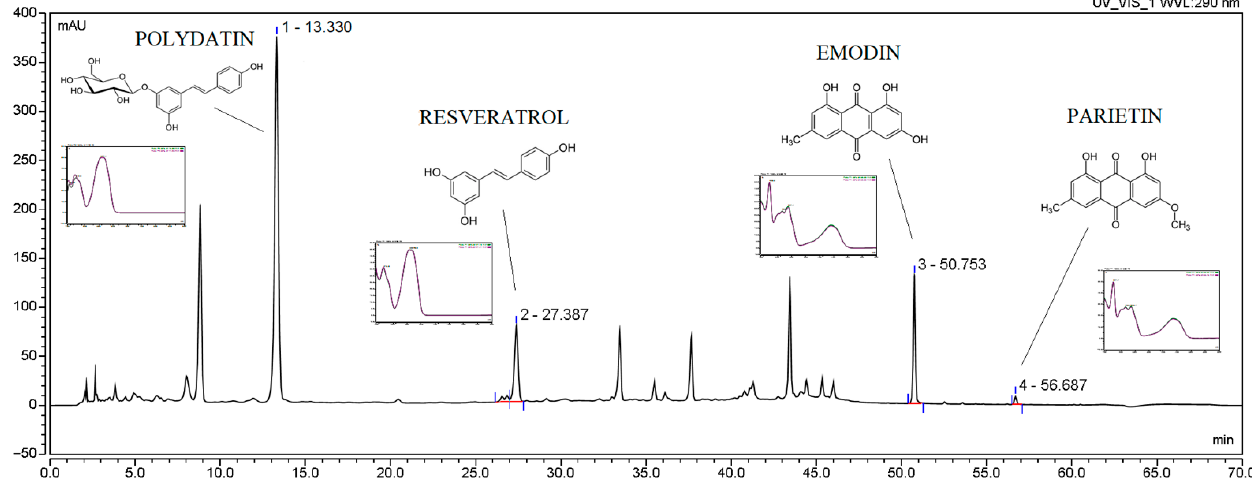
Figure 1. Chromatogram of extract W9. Table 3. Content of Active Compounds in the Extracts.